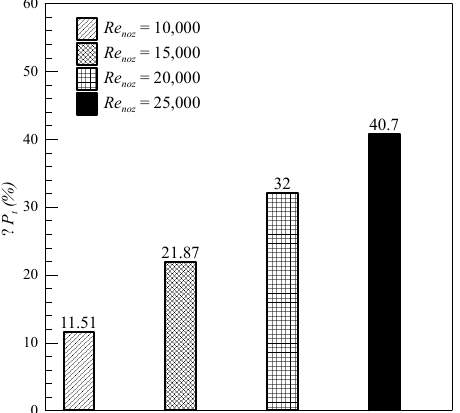
ff erent Re noz